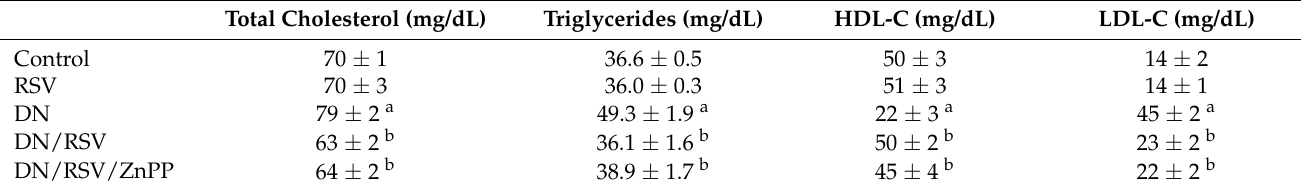
Table 3. Effect of rosuvastatin (RSV) on lipid profile in diabetic nephropathy (DN) in rats. Total Cholesterol (mg/dL)